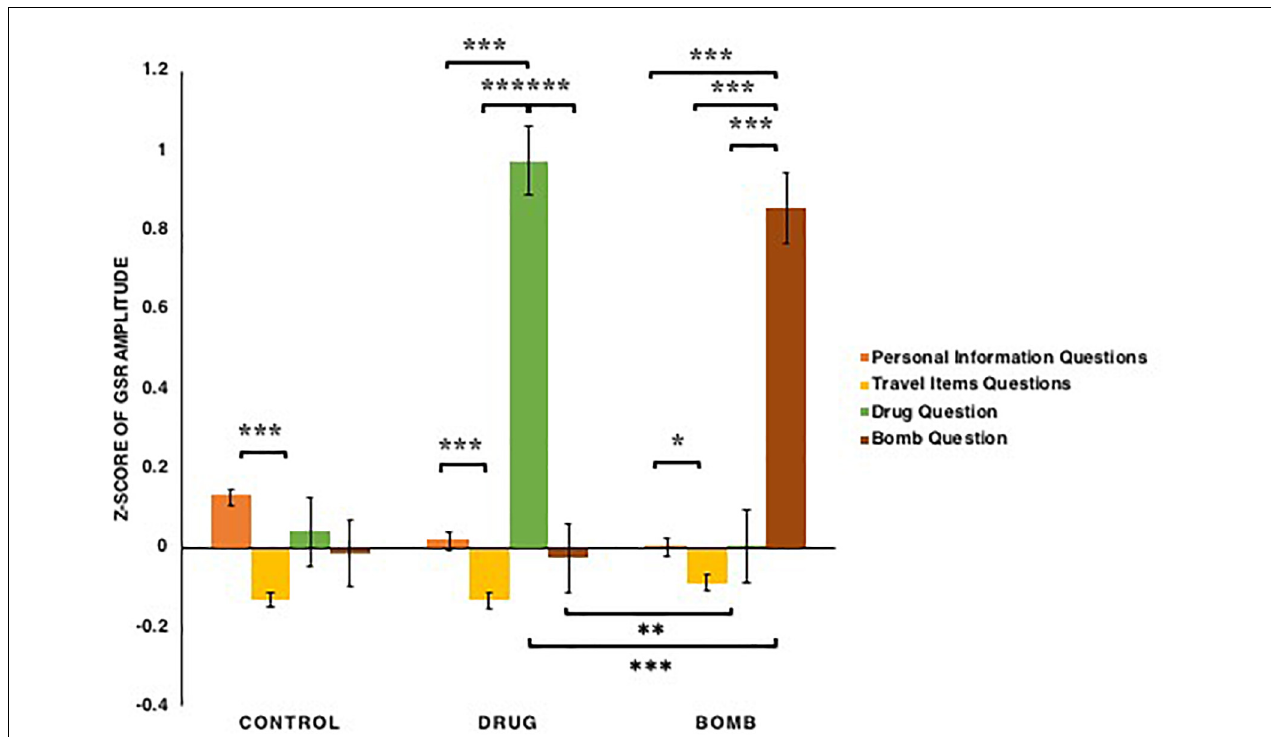
FIGURE 10 | The z -scores of the peak-to-peak amplitude of GSR among participants in the bomb, control and drug conditions across the types of questions: basic personal information, carrying common travel items, carrying drugs, carrying a bomb. Note that ∗ p < 0.05, ∗∗ p < 0.01, ∗∗∗ p < 0.001. The error bars SEs.